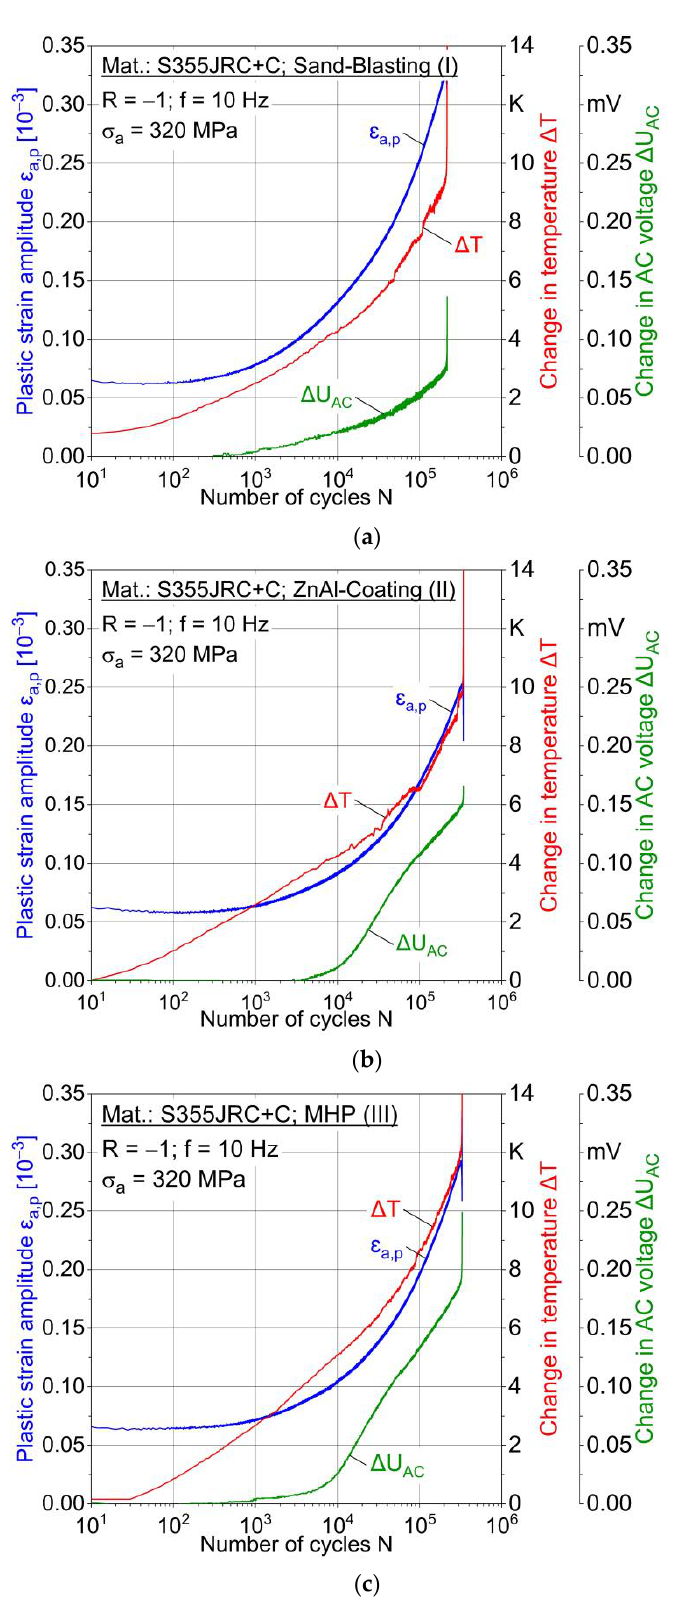
Figure 16. Constant amplitude tests (CAT) at 320 MPa for ( a ) sandblasted (I), ( b ) ZnAl-coated (II) and ( c ) machine hammer-peened (III) specimens.